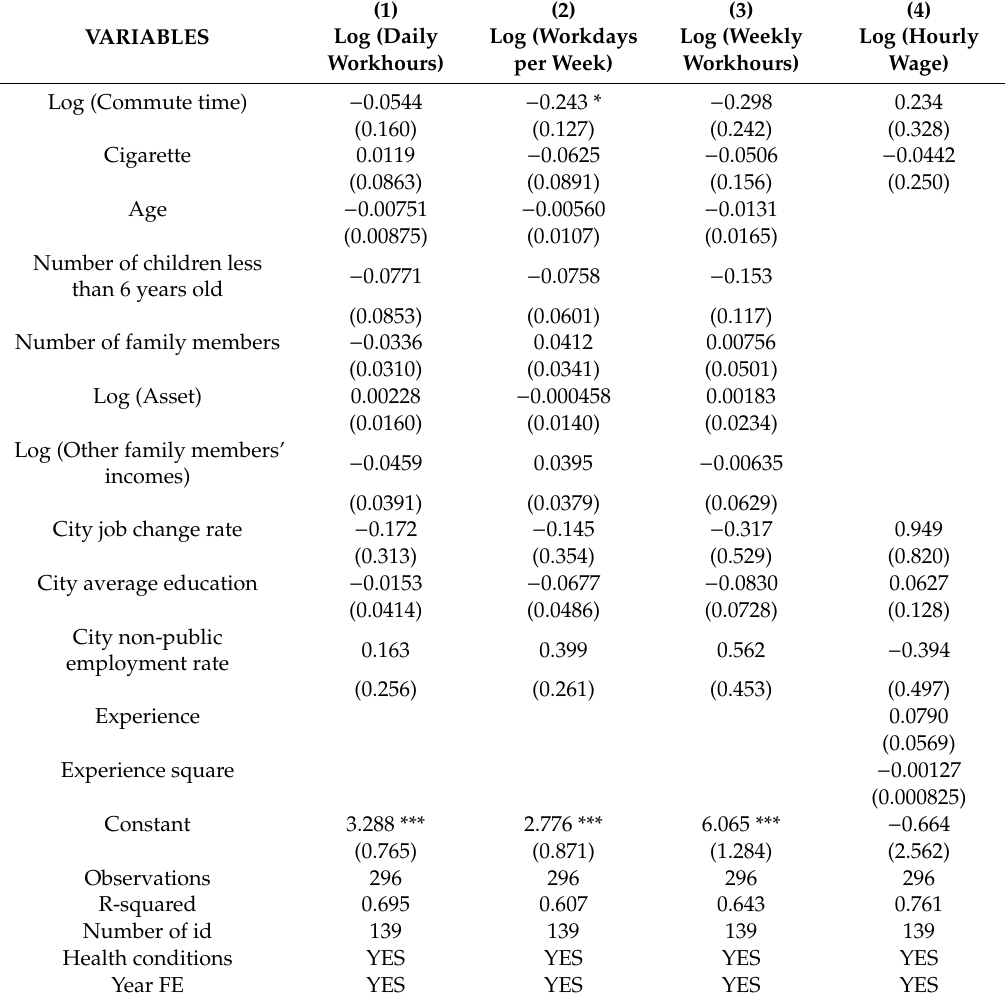
Table 7. Labor supply and wage for job changed